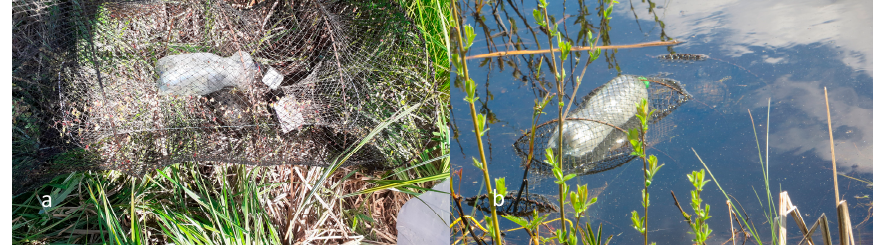
Figure 2. Fyke traps in the study: ( a ) prepared and used for catching; ( b ) deployed in a pond. Due to differences in the sizes of the surveyed ponds, the numbers of amphibians caught or visually counted in areas of the same area or the number of amphibians per 36 traps per day from each pond were averaged and